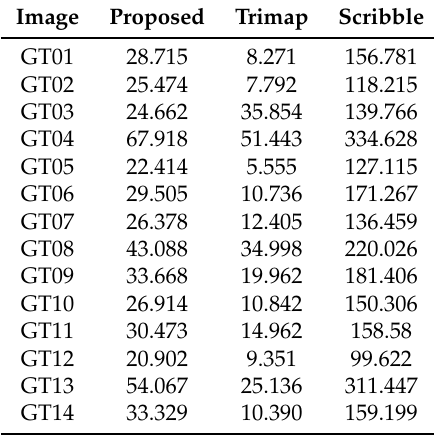
Figure 8. Partial trimap comparison results of experiment 1. The first column represents the original image (selected from [45]). The last column represents the user input trimaps (selected from [45]). The second column represents the trimaps generated by the proposed method. The third column represents the optimized trimaps (by trimap trimming [15]). Table 2. Mean absolute error (MAE) statistics of alpha matte computation on [45] (using [13]). The proposed method obtains a approximate MAE to the trimap-based image matting, and is much more accurate than scribble-based image